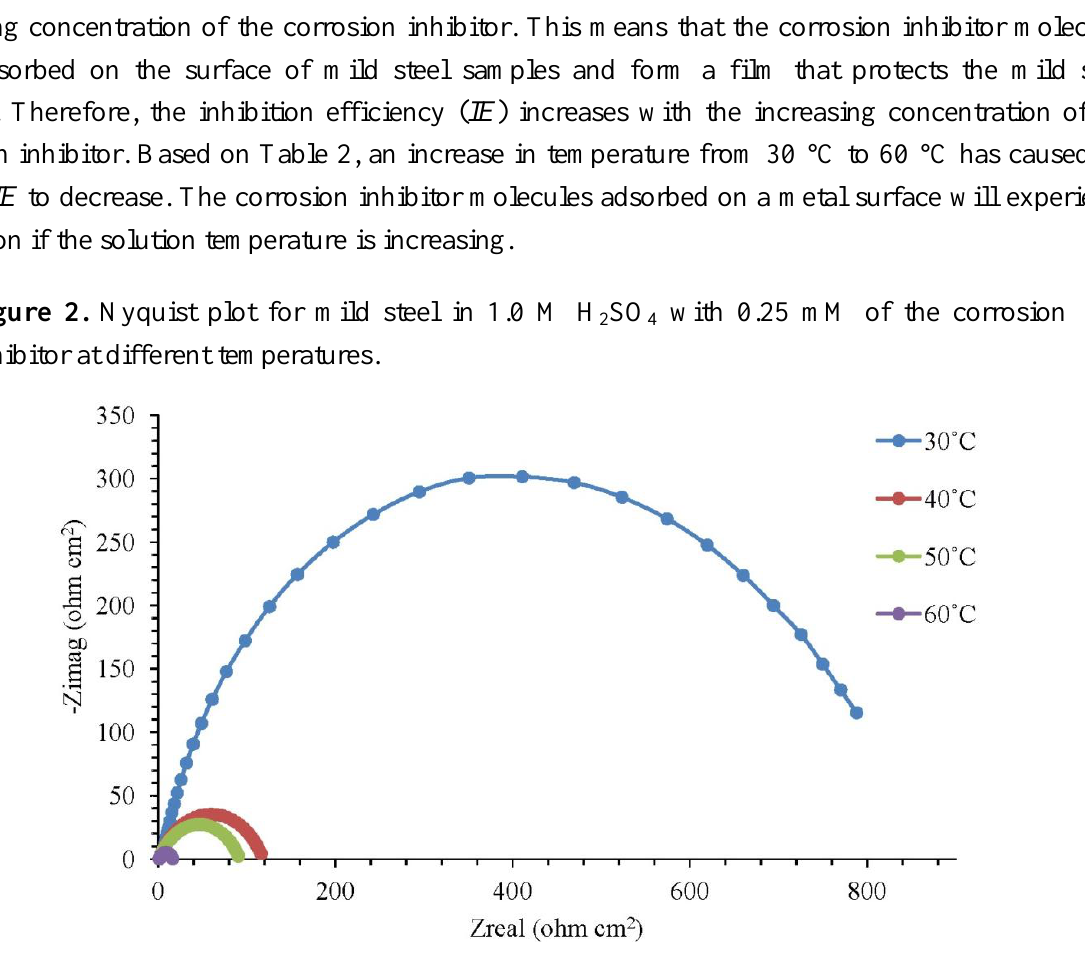
Table 1. Data of constant phase element ( CPE ) matching for mild steel in 1.0 M H with different concentration of the corrosion inhibitor at 30 °C. R charge transfer of resistance; C